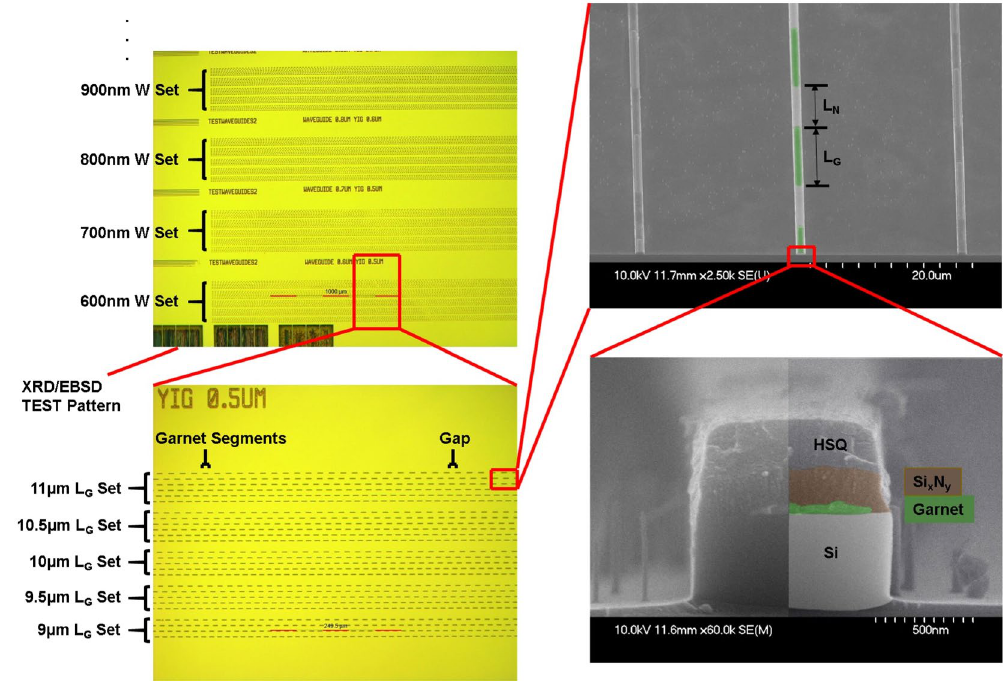
Figure 2. Monolithic integration of Faraday Rotation waveguide isolators. Optical (left) and scanning electron (right) micrographs showing the SOI waveguides with different widths (W), different garnet segment lengths (L G ), and a cross section of Bi:TIG cladding on SOI waveguides with performance shown below.